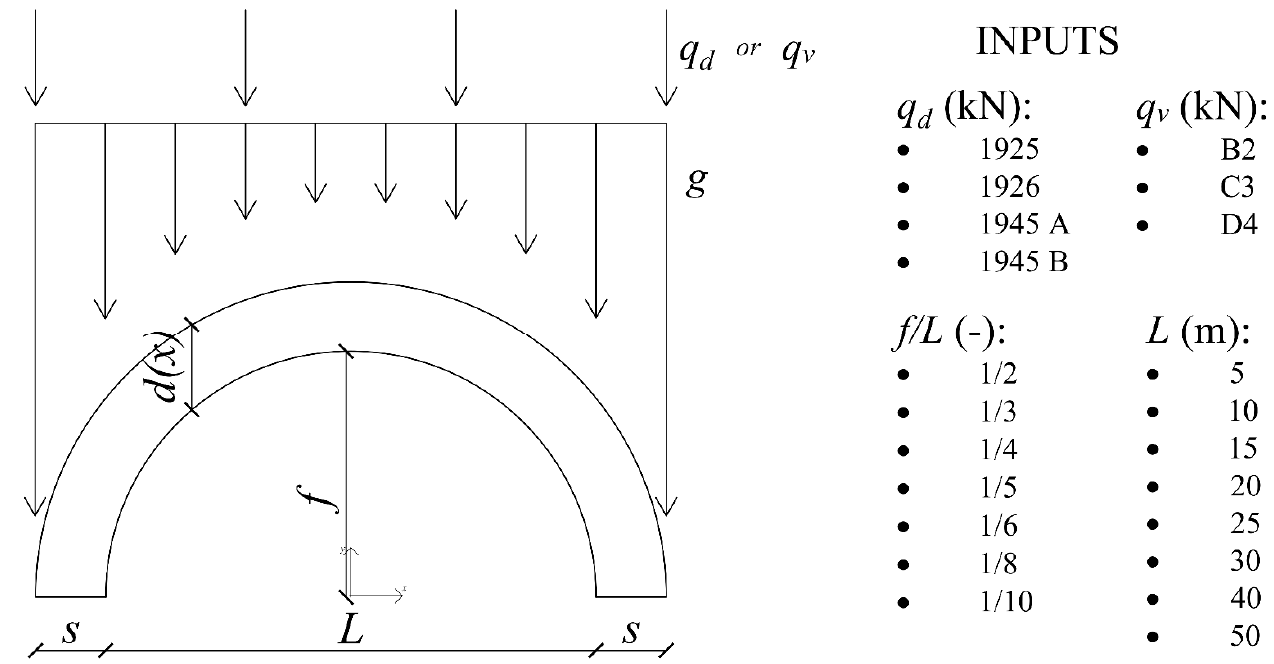
Figure 7. Inputs of the parametric analysis. To obtain results on the safe side, conservative assumptions were made on the geo- metrical quantities, and neither the fill layer above the crown of the arch, nor the ballast, were considered ( c = 0 m, b = 0 m). The arch thickness was set as B = 3.5 m. The unit weights γ AR = 20 kN/m 3 , γ BALL = 18 kN/m 3 , and γ FILL = 18 kN/m 3 were considered for the masonry, ballast, and fill layer, respectively, and the train-track load was assumed q TT = 2 kN/m 2